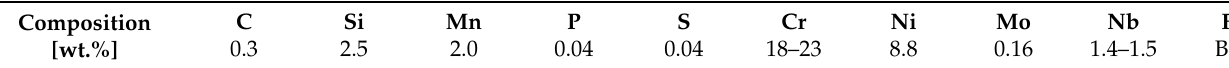
Table 2. Chemical composition of austenite stainless steel.